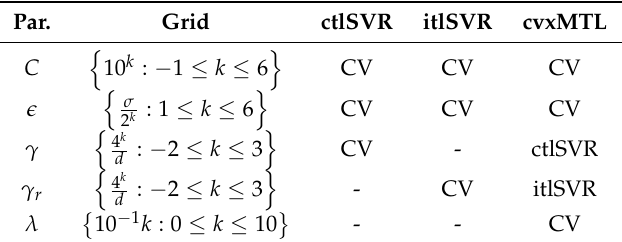
Table 1. Hyperparameters, grids used to find them (when appropriate), and hyperparameter selection method for each model. Here, d is the number of dimensions of the data and σ is the standard deviation of the target. Par. Grid ctlSVR itlSVR